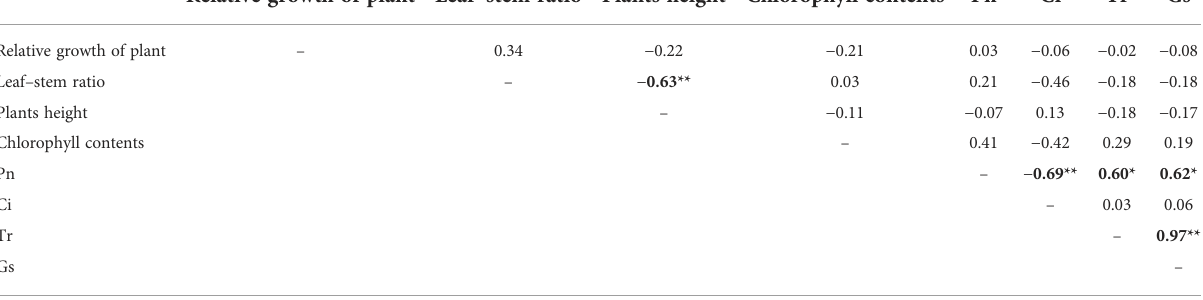
TABLE 2 Pearson ’ s correlation coef fi cients between pairs of traits. Relative growth of plant Leaf – stem ratio Plants height Chlorophyll